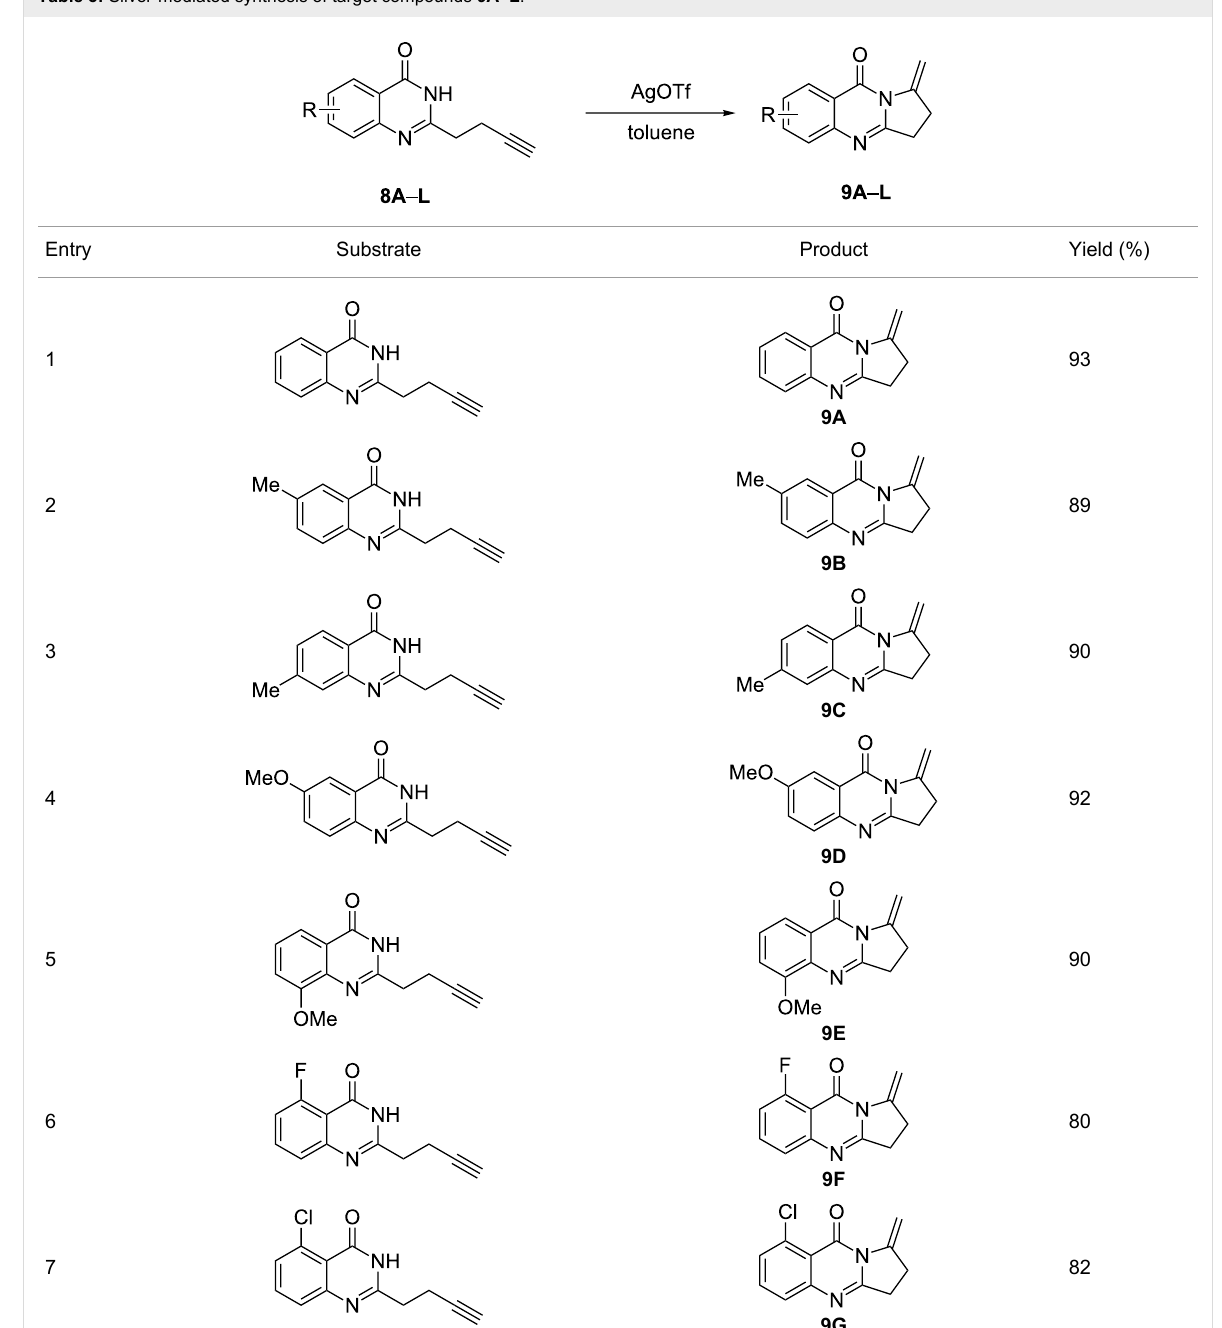
Table 3: Silver-mediated synthesis of target compounds 9A–L . a